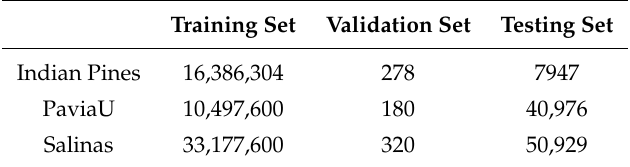
Table 5. The sizes of training sample-pair set, validation sample-pair set and testing sample-pair set for The Three Data Sets: Indian Pines, PaviaU and Salinas. Here the number of spatial window K set to be 4 and the corresponding spatial window size are 5 × 5, 7 × 7, 9 × 9 and 11 ×